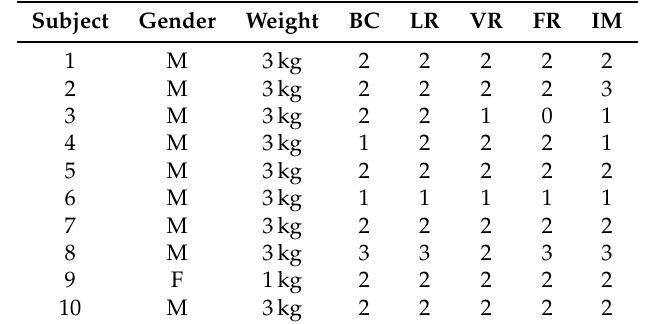
Figure 2. The four exercise types used in the experiments: starting and ending positions of each repetition. Source: http://db.everkinetic.com, licensed under the Creative Commons Attribution-Share Alike 4.0 International Public License. Table 1. Database consistency: number of sets performed by each subject for each exercise type, with the specified dumbbell